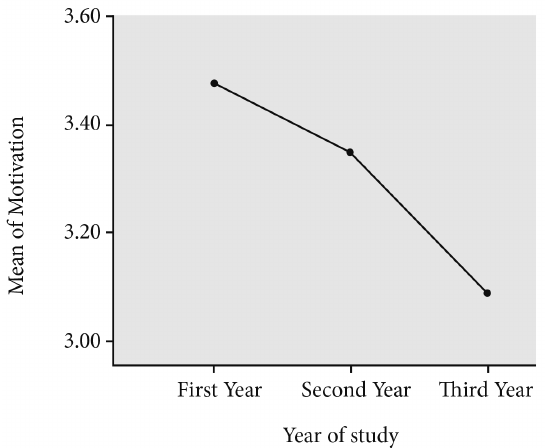
Mean of motivation versus year of study results in South African design students (Source: Authors, 2020).